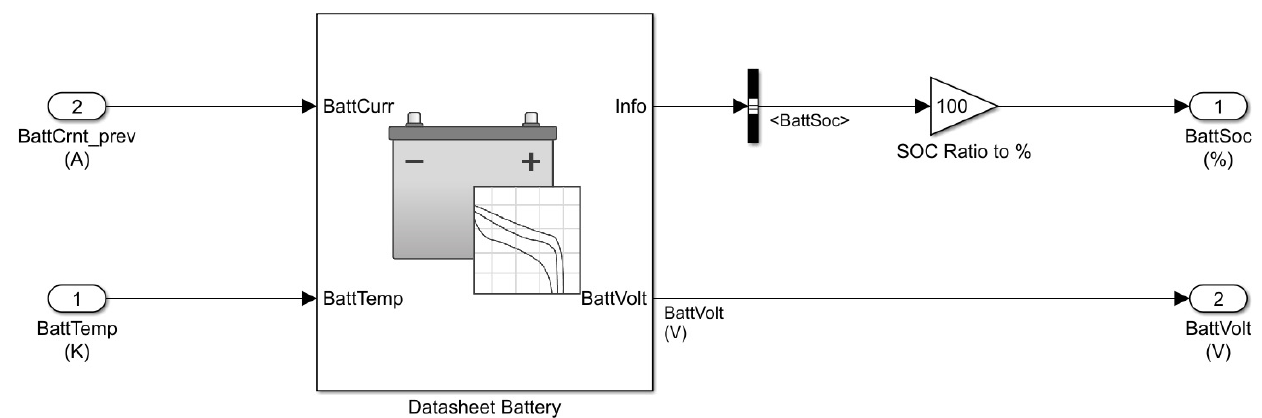
Figure 2. The “Datasheet Battery” block and its connections with model parameters. The “Datasheet Battery” block is present in the “Simulink Library Browser” in the “Powertrain Blockset”.